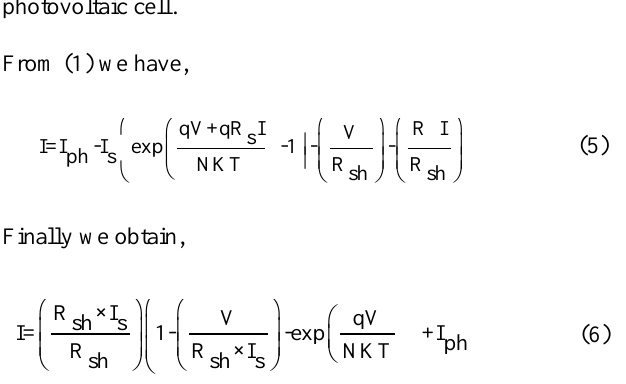
Figure 2 . I-V curve of photovoltaic Cell. In the I-V curve of a PV cell, there is short circuit current where the current has its maximum value. And the maximum value of voltage is open circuit voltage [6]. The curve plotted in figure 2 shows the behaviour of the current with respect to its voltage. curve of a PV cell. In that curve there is a point where power is maximum is called maximum power point (MPP) [2]. Maximum power point is calculated at the highest point of power-voltage curve and at the knee point of a current-voltage